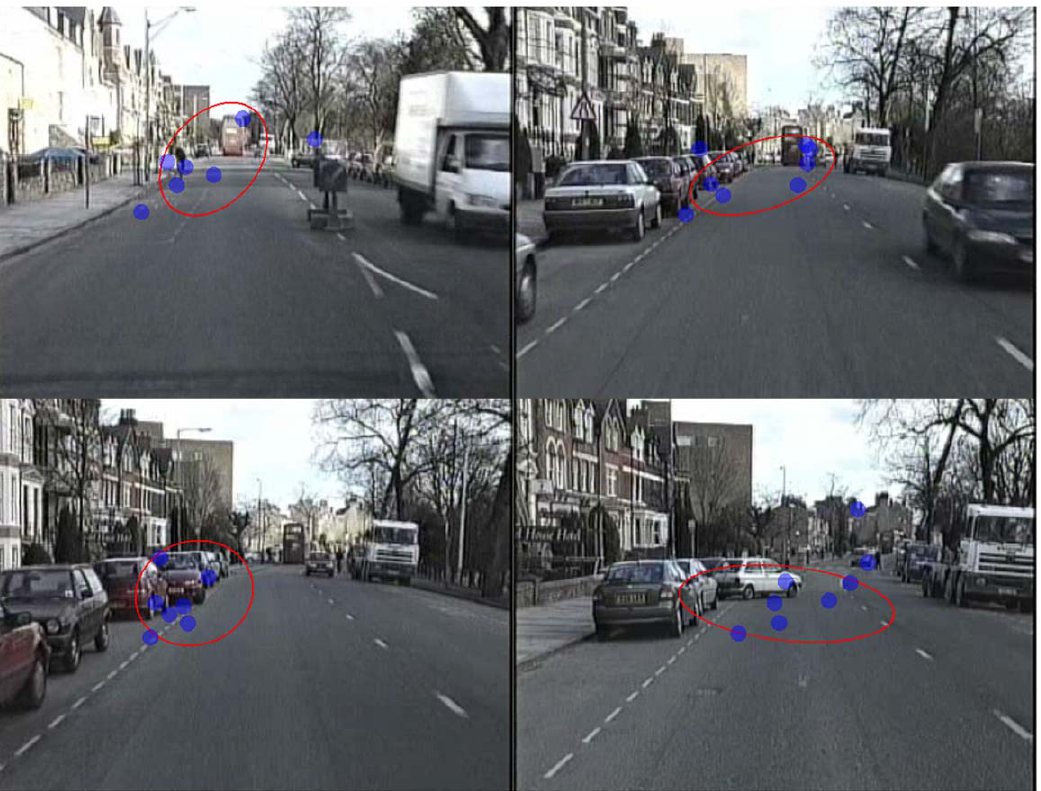
Figure 2. Novel ‘Point of Regard’ Analysis. Examples of the BCE ‘point of regard’ analysis superimposed on frames from some of the HPT films. The centre of the red ellipse represents the mean ‘point of regard’ of the controls with the spatial extent of the ellipse being one standard deviation from this centre along two principal axes, theoretically affording ‘coverage’ of approximately 67% of the ‘point of regard’ locations in a given frame. Note how the location and spatial extent of this ellipse changes with each frame of the film as the control subjects’ view is drawn to different aspects of the changing road scene. For each frame the number of patients’ points of regard (blue symbols) ‘captured’ by the ellipse can be automatically counted and compared to the expected value under the null hypothesis that the average ‘viewing area’ is the same in the two groups. Note that not all nine patients are recorded in each frame because of blinks, loss of data, and variable responses. Also, note that in the UK vehicles are driven on the left hand side of the road. See Audio/Video - S1.